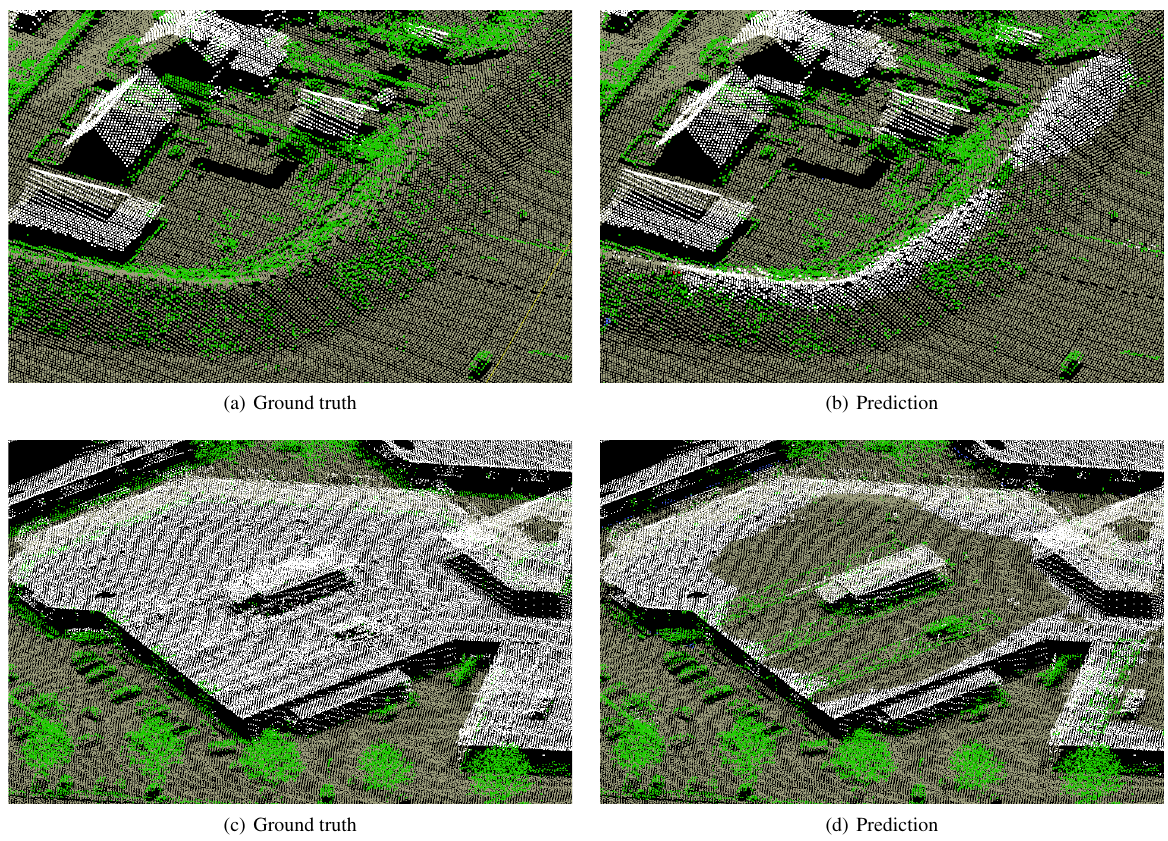
Figure 8. Examples of misclassified AHN3 points, predicted at 0 . 25 m voxel resolution. The large building is roughly 150 m wide. Green: unassigned; brown-gray: ground; white: buildings; blue: water; red: bridges. Best viewed digitally.